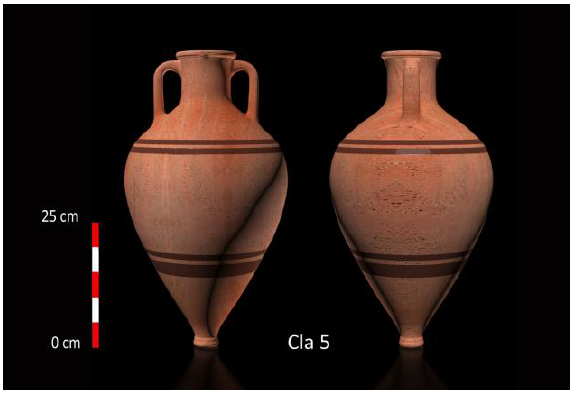
Figure 7. A Clazomenian amphora from the same period